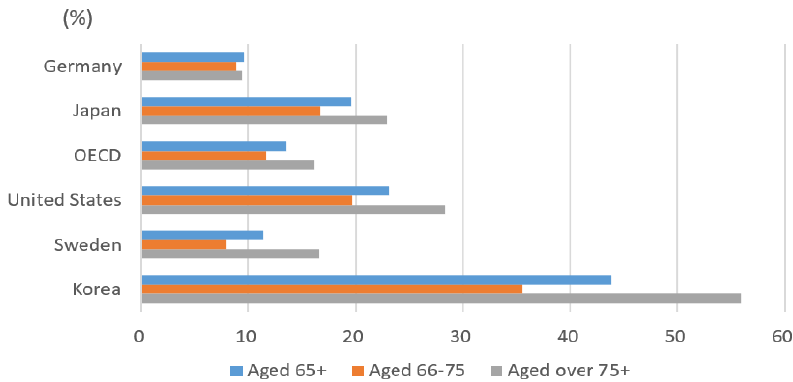
Figure 4. Poverty rate among older age groups (2016). Source: OECD [6].